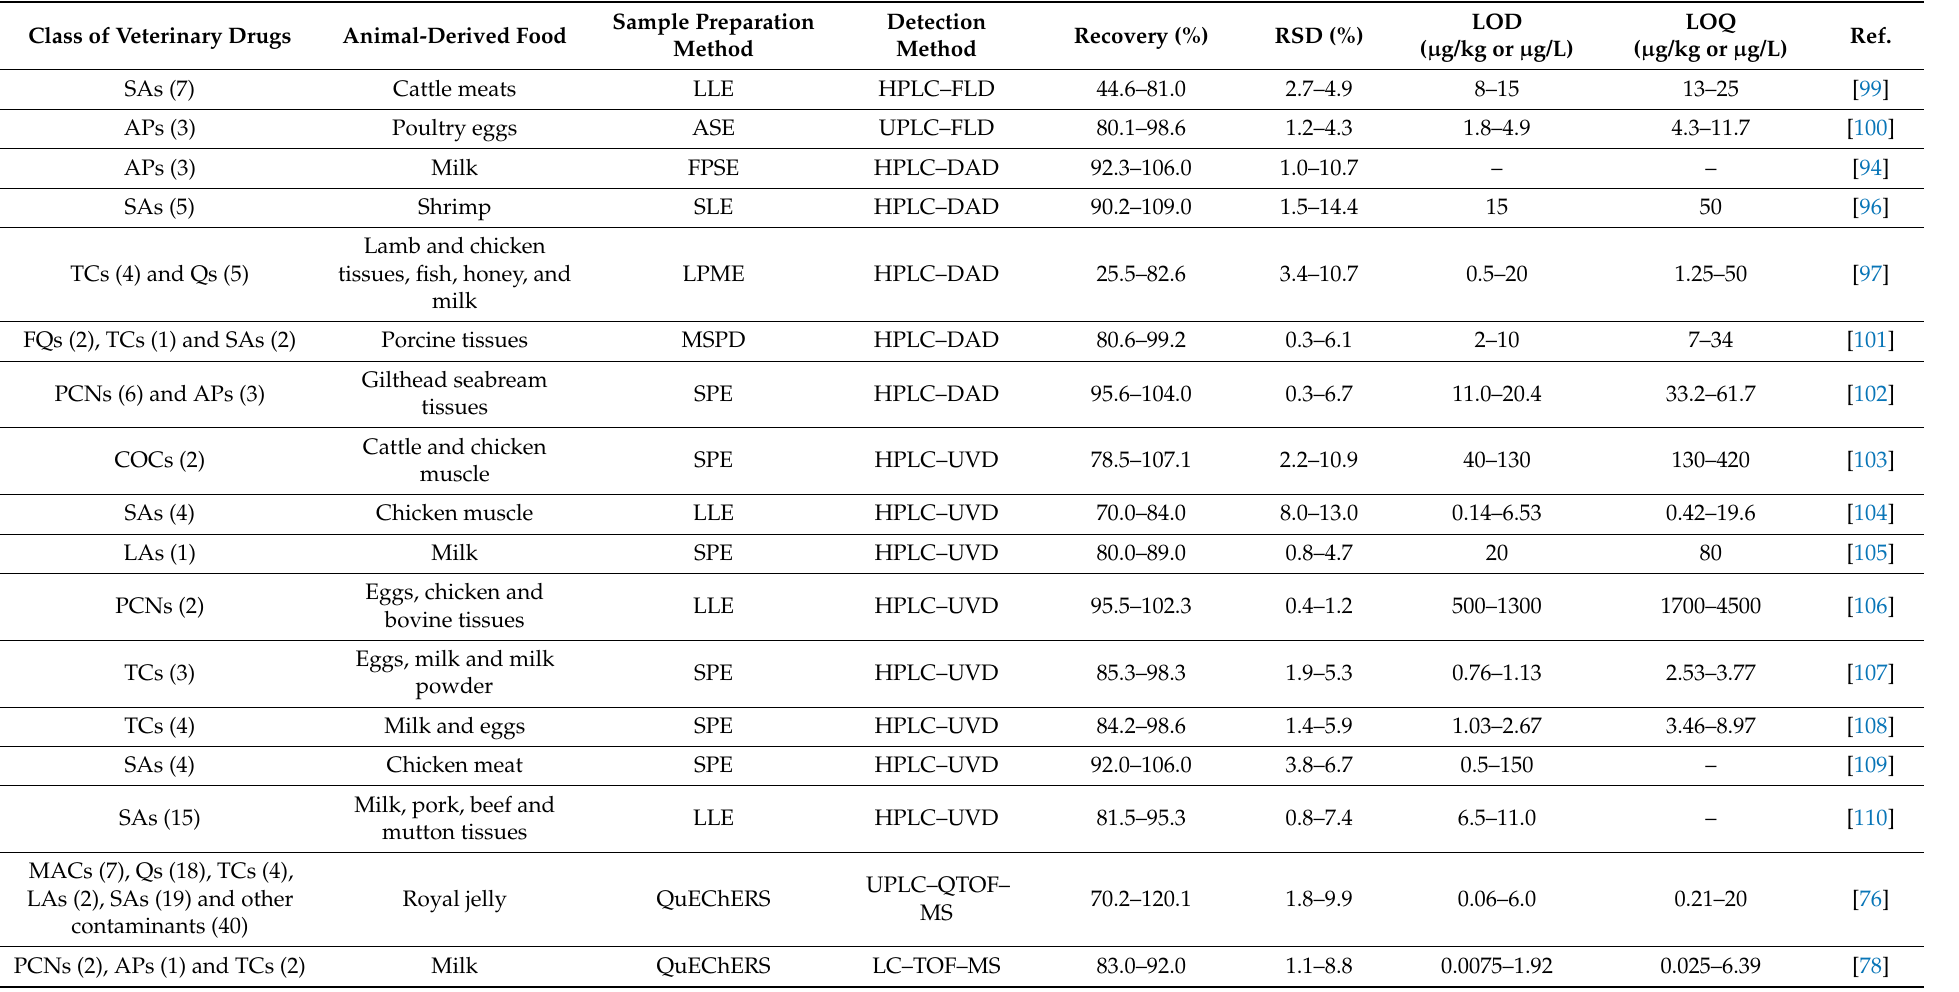
Table 4. Overview of published LC and GC methods for the analysis of veterinary drugs in animal-derived